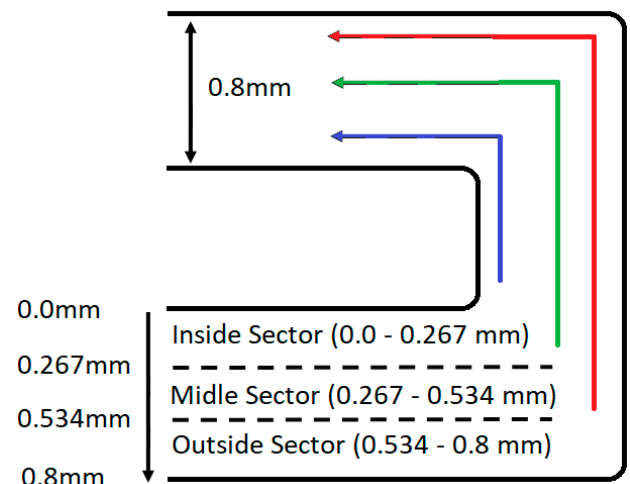
Figure 4. Drawing illustrates the three sections of the microfluidic channel.